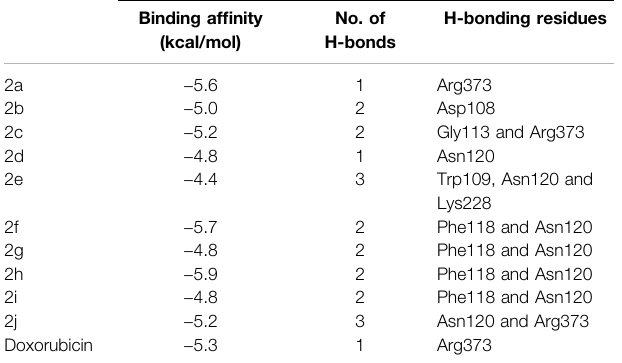
TABLE 3 | Molecular docking interaction of compounds 2a-2j and Doxorubicin against protein 1Z11. Compound